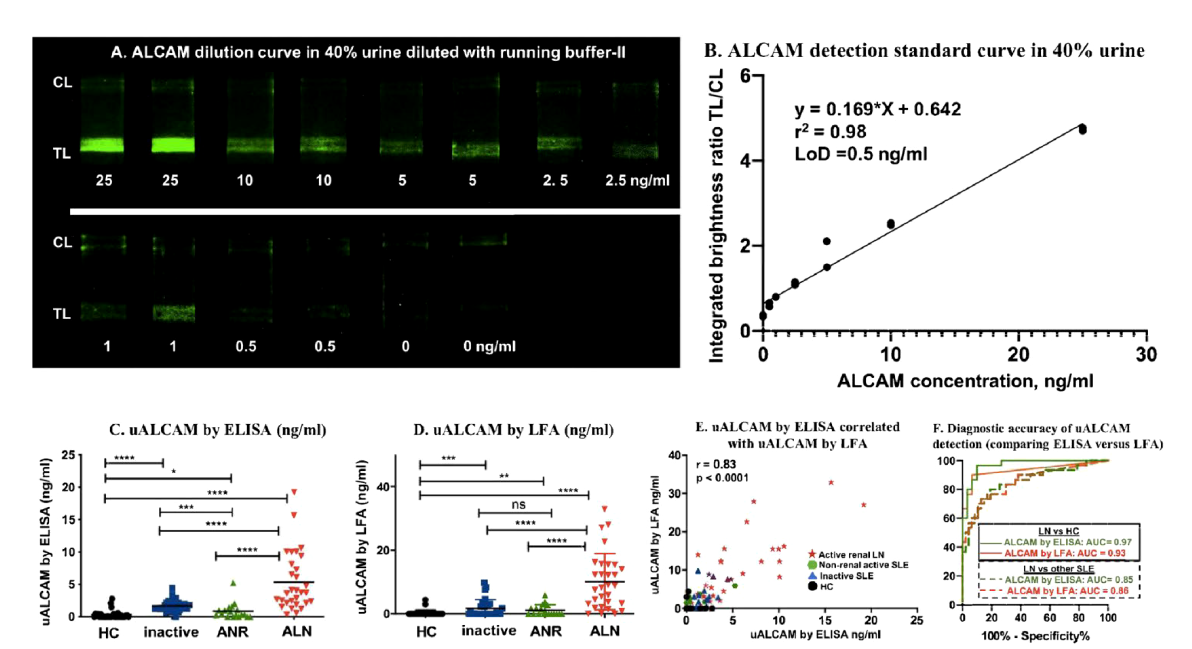
FIGURE 4 uALCAM detection by LFA and ELISA in clinical samples. (A) Samples from ALCAM standard curve constructed in 40% urine were run on ALCAM LFA using lyophilized anti-ALCAM nanophosphors. (B) The ALCAM standard curve LFA strips were imaged using a smartphone, and the correlation of ALCAM concentration with TL/CL ratios is shown. This regression equation was then used to convert the LFA TL/CL ratios observed in the clinical samples to ALCAM concentration. The column graphs showed the uALCAM levels in four groups of samples (30 HC, 29 inactive, 18 ANR, and 30 ALN) as assayed by ELISA (C) and LFA (D) The plots show the mean concentration in urine for each disease group. *p < 0.05, **p < 0.01, ***p < 0.001, ****p < 0.0001 as determined using Mann – Whitney U-test. (E) Plotted is the Pearson correlation of uALCAM assayed by ELISA versus uALCAM assayed by LFA. (F) uALCAM as assayed using LFAs had the capacity to distinguish ALN patients from healthy subjects with high accuracy values (ROC AUC=0.93, solid red line) and from all other lupus patients (ROC AUC=0.86, dashed red line), and were very comparable to the performance metrics of the conventional ELISA assay. HC, healthy control; inactive, inactive SLE patients; ANR, active non-renal SLE patients; ALN, active renal lupus nephritis